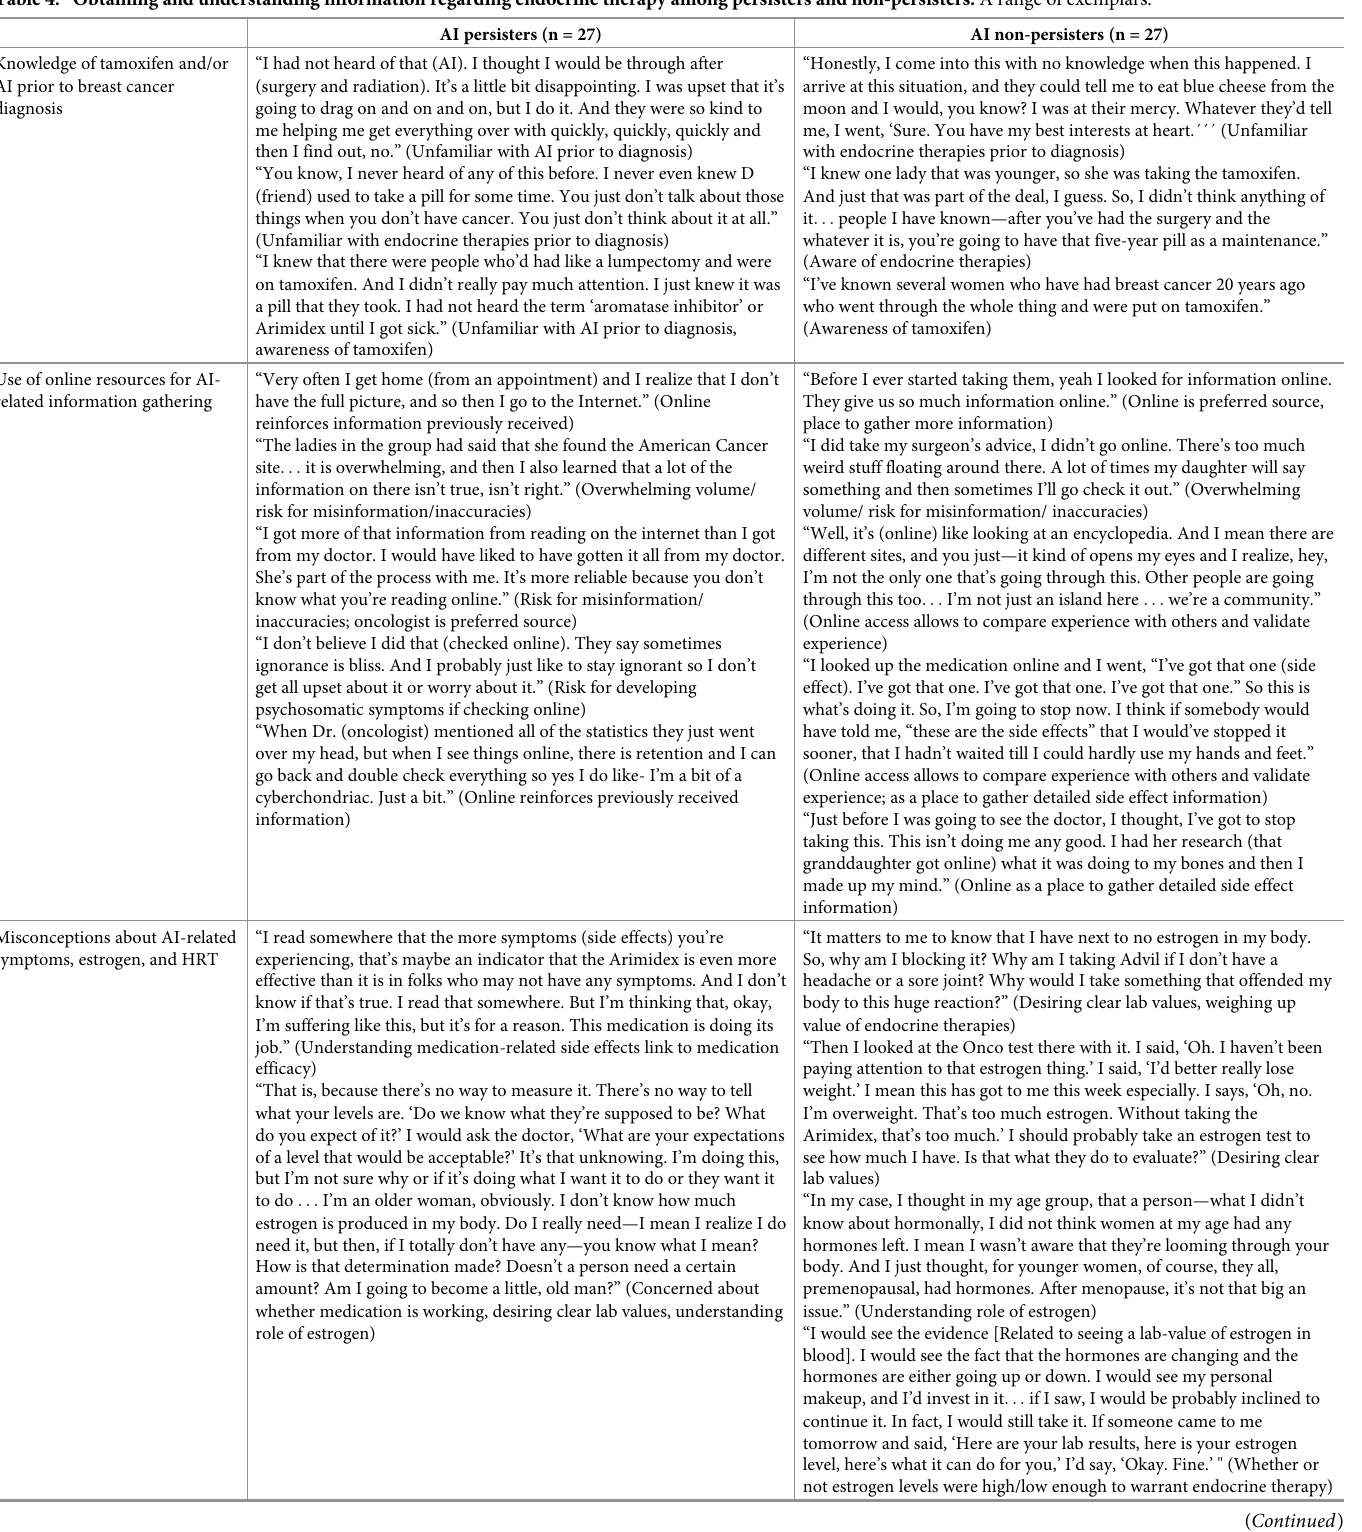
Table 4. Obtaining and understanding information regarding endocrine therapy among persisters and non-persisters: A range of exemplars. AI persisters (n = 27) AI non-persisters (n = 27) Knowledge of tamoxifen and/or AI prior to breast